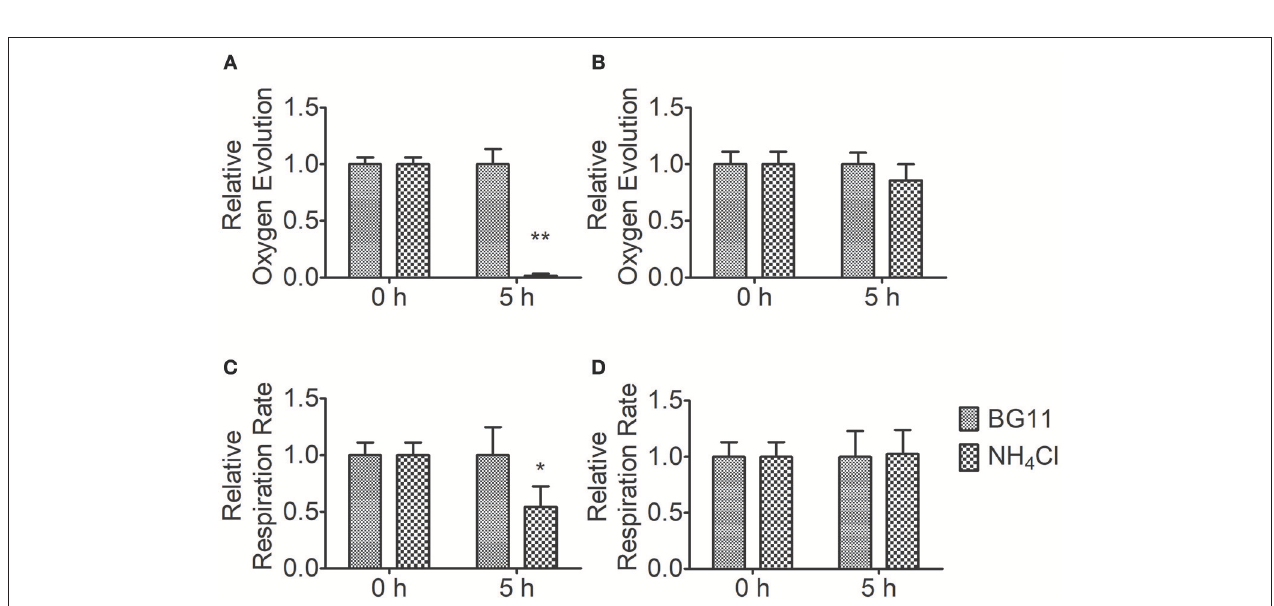
FIGURE 6 | Relative photosynthetic oxygen evolution rate and respiratory oxygen consumption of Chlorella strains FACHB-1216 and FACHB-1563 cultured in BG11 and 1g L − 1 NH 4 Cl. (A,B) Represent the photosynthetic oxygen evolution of Chlorella strain FACHB-1216 and FACHB-1563, respectively; (C,D) Represent the respiratory oxygen consumption of Chlorella strain FACHB-1216 and FACHB-1563, respectively. The significance of the differences between the same sample at 0h and 5h was tested using a one-way ANOVA. * P < 0.05; ** P < 0.01.